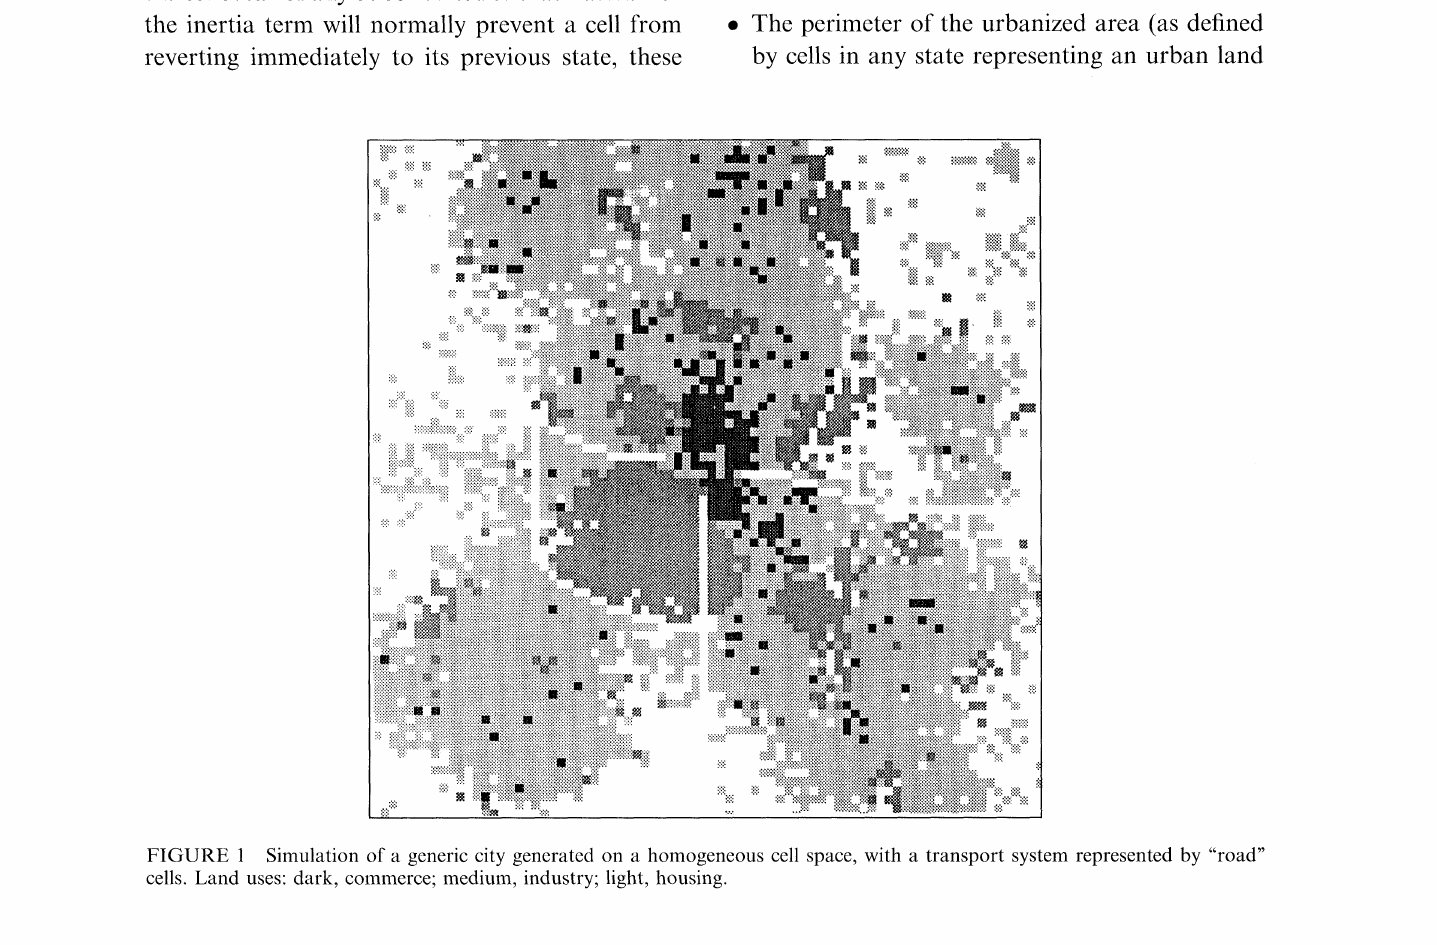
FIGURE Simulation of a generic city generated on a homogeneous cell space, with a transport system represented by "road" cells. Land uses: dark, commerce; medium, industry; light,